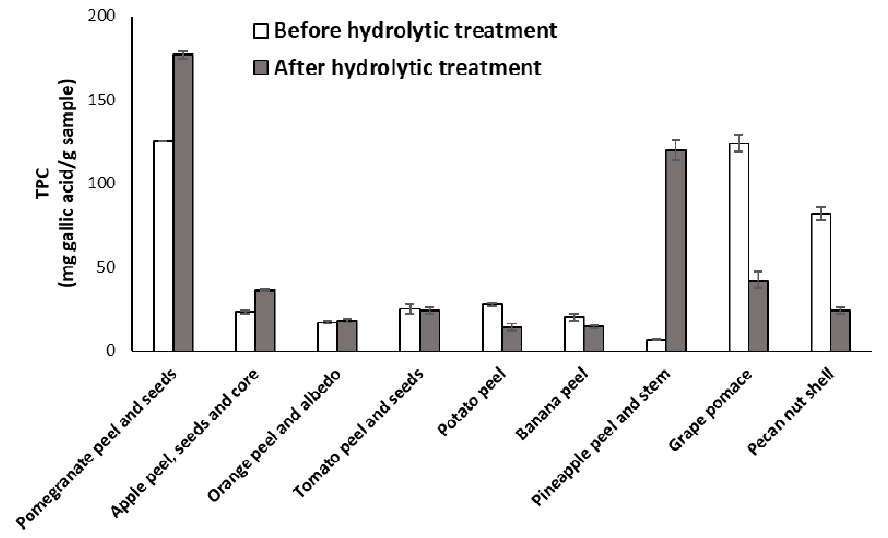
Figure 2. TPC of agri-food byproducts before and after hydrolytic treatment. Reported are the mean ± SD values of at least three experiments.